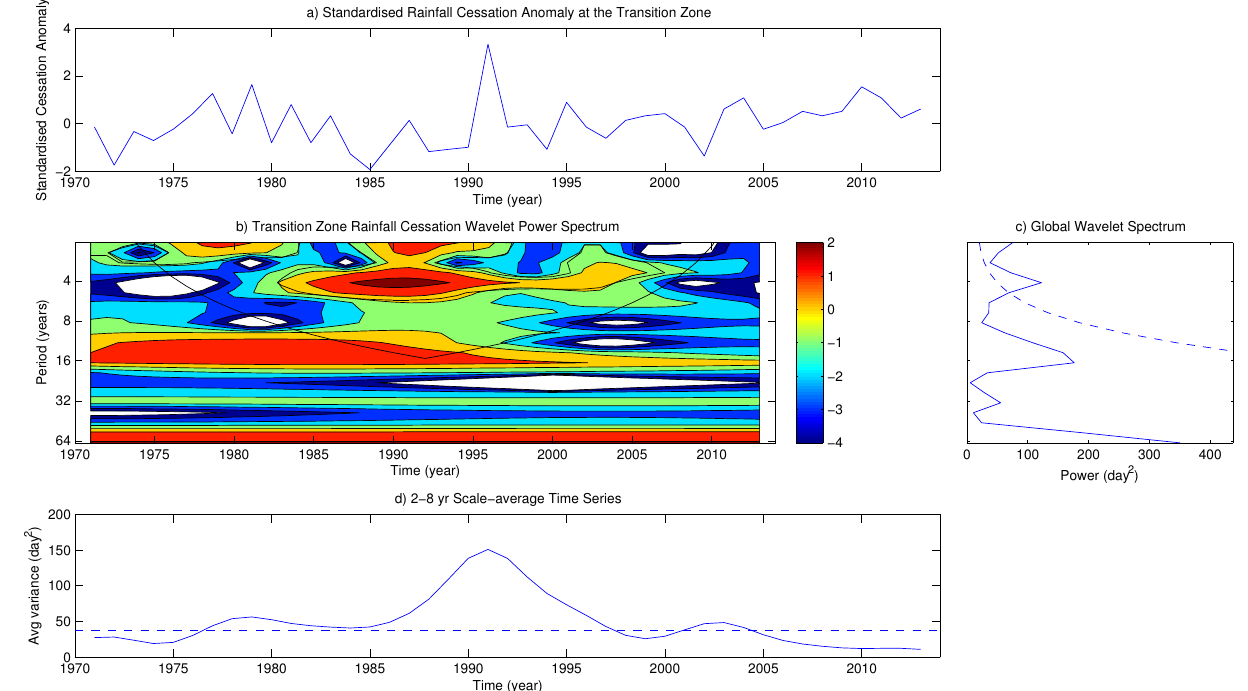
Figure 9. Interannual variability of rainfall cessation dates for the transition zone using wavelet analysis. ( a ) Standardized anomaly of cessation; ( b ) as in Figure 6, but for cessation; ( c ) as in Figure 6; ( d ) as in Figure 6; the dashed line shows the 95% confidence level.